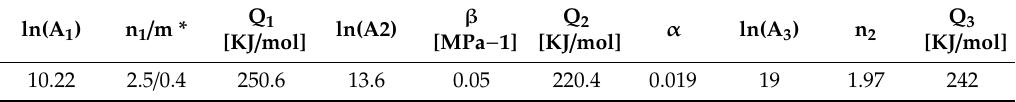
Table 2. The computed values of the constants of both simple power law and hyperbolic sine equations.